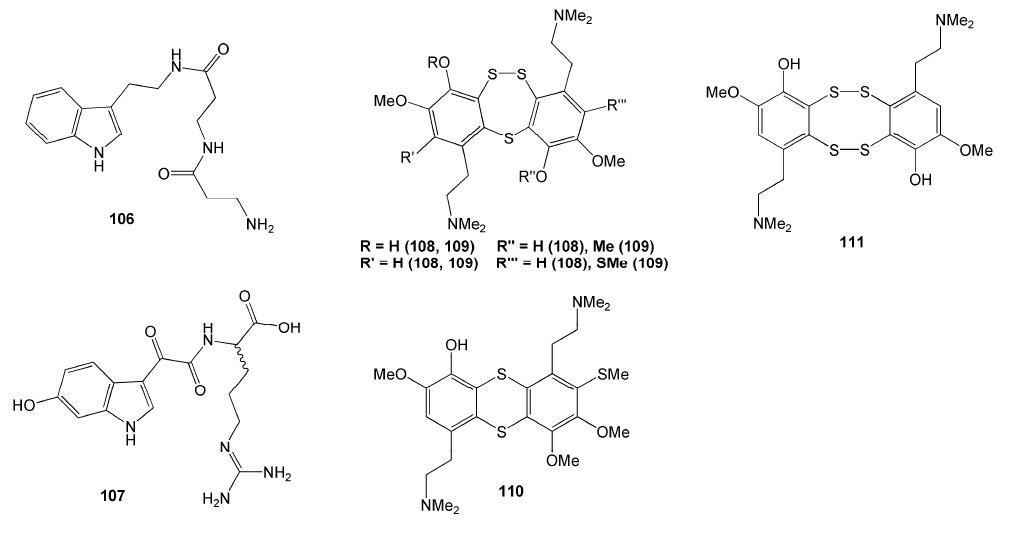
Figure 10. Chemical structures of 106 – 111. Table 2. Summary of the marine natural products isolated from the marine tunicates from Indonesian oceans.